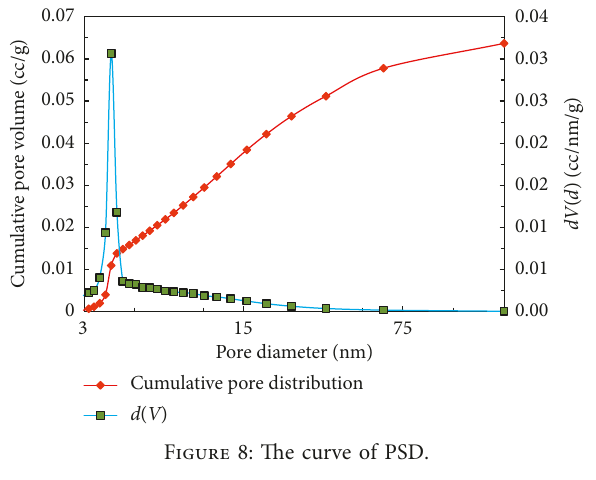
Figure 8: The curve of